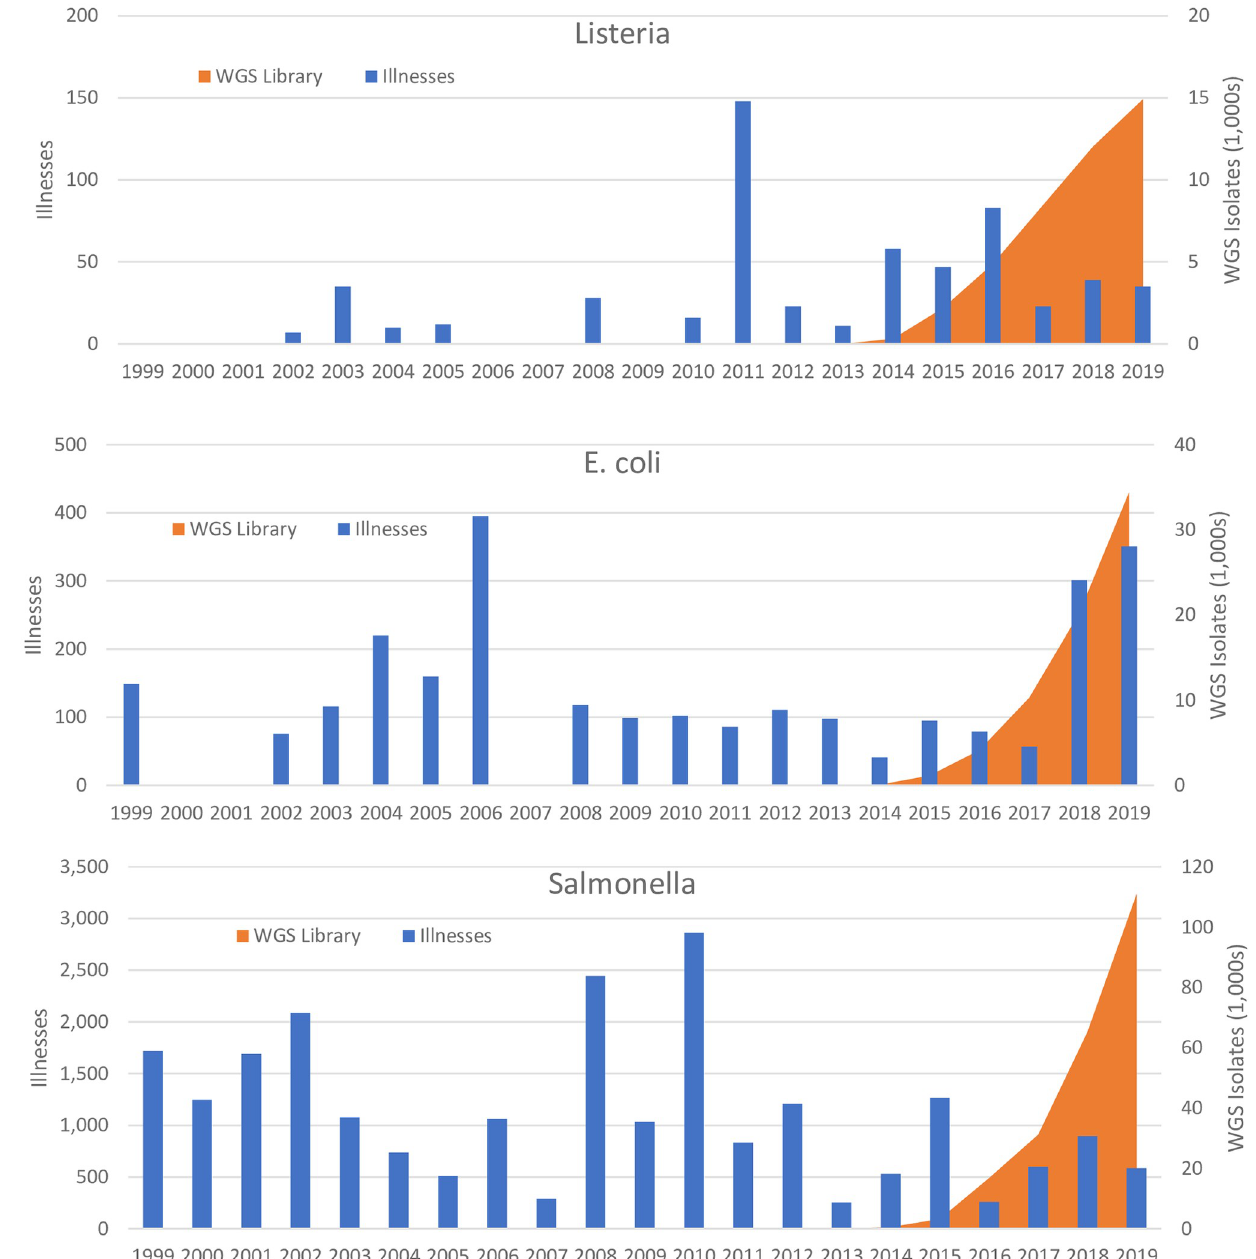
Fig 1. Illnesses & WGS isolates by pathogen. WGS, Whole Genome Sequence. Annual Illnesses for Listeria , E . coli ., and Salmonella foodborne illnesses related to U.S. Food and Drug Administration regulated products charted against the number of unique isolates found in the National Center for Biotechnology Information’s database of sequenced isolates over